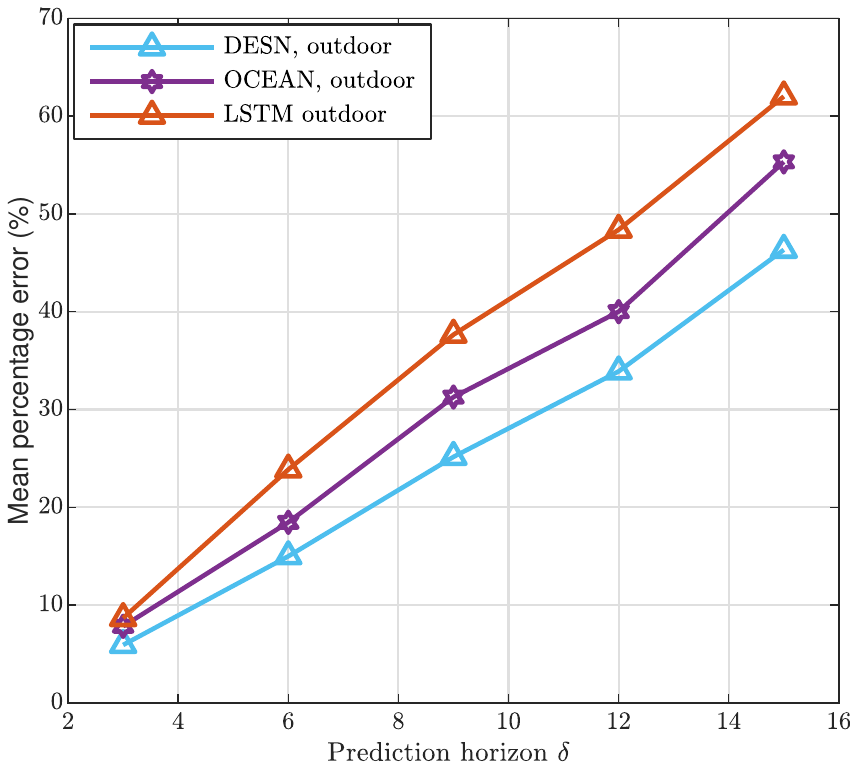
Figure 8. Outdoor mean absolute percentage